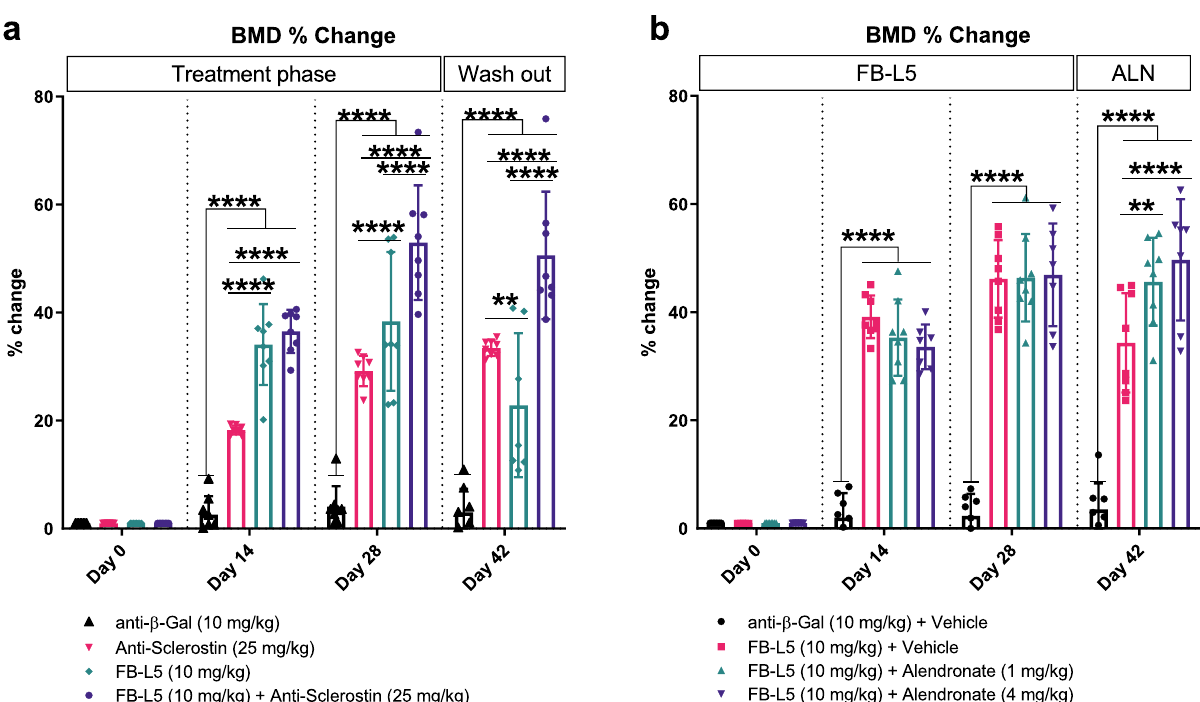
Fig. 7 Combination studies of Wnt mimetic antibodies with currently available therapeutics. a 12-week-old C57BL6/J female mice were injected bi- weekly for 28 days with intraperitoneal administration of FB-L5 (10 mg/kg) antibody and compared to a negative control anti- β -gal (10 mg/kg) and positive control bi-weekly subcutaneous administration of 25 mg/kg anti-sclerostin antibody or a combination of anti-sclerostin antibody and FB-L5. A 2- week washout period then followed (day 42 assessment). Longitudinal DEXA measurements were collected and whole-body % BMD change quanti fi ed for days 0, 14, 28, and 42, normalized to baseline. At day 28, combination treatment induced statistically signi fi cant increases in BMD compared to individual treatments. At day 42, combination treatment maintained the bone accrual gained during the fi rst 4 weeks of treatment and remained statistically signi fi cant compared to individual treatments. b 12-week-old C57BL6/J female mice were injected bi-weekly for 28 days with intraperitoneal administration of FB-L5 (10 mg/kg) antibody and compared to a negative control anti- β -gal (10 mg/kg). From day 28 through day 42, animals were treated with either vehicle or alendronate at 1 or 4 mg/kg. Longitudinal DEXA measurements were collected and whole-body % BMD quanti fi ed for days 0, 14, 28, and 42, normalized to baseline. a , b Graphs represent mean values ± SD, n = 8 mice/group. Statistical signi fi cance determined by two-way ANOVA (** p < 0.01, **** p < 0.0001), where the following letters de fi ne groups, a (a = anti- β -Gal, b = Anti-Sclerostin, c = FB-L5, d = FB-L5 + Anti-Sclerostin) and b (a = anti- β - Gal + Vehicle, b = FB-L5 + Vehicle, c = FB-L5 + Alendronate (1 mg/kg), d = FB-L5 + Alendronate (4 mg/kg)). a Day 14, a vs. b, p ≤ 0.0001, a vs. c, p ≤ 0.0001, a vs. d, p ≤ 0.0001, b vs. c, p ≤ 0.0001, b vs. d, p ≤ 0.0001. Day 28, a vs. b, p ≤ 0.0001, a vs. c, p ≤ 0.0001, a vs. d, p ≤ 0.0001, b vs. c, p ≤